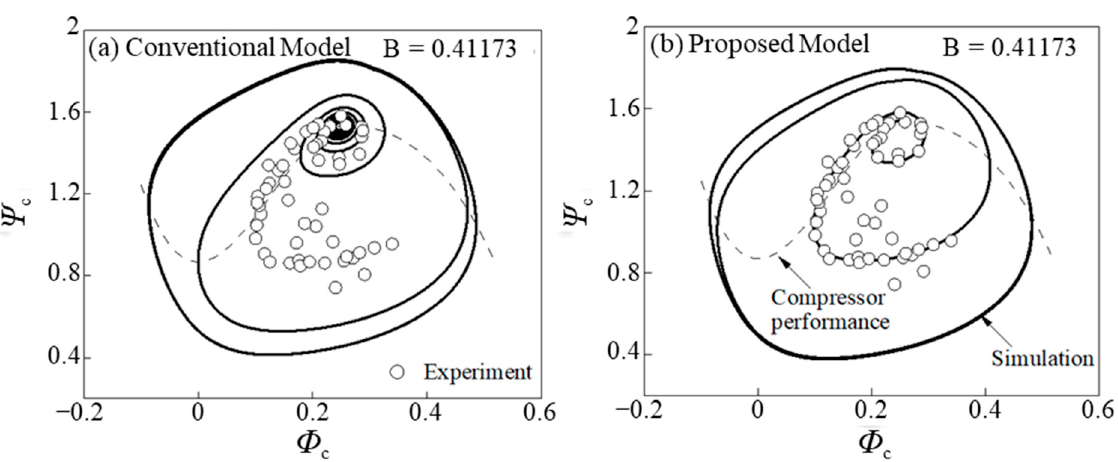
Figure 9. Comparison of the proposed model and the conventional model for surge parameter B = 0.41173.